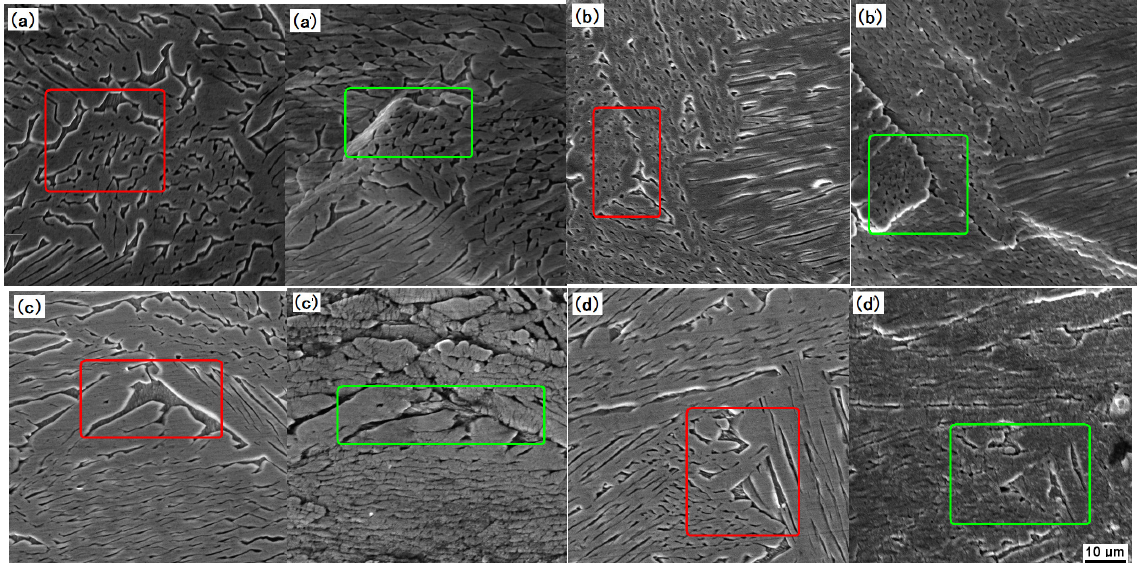
Figure 6. Microstructure before and after upsetting as initial temperature 20 °C, 300 °C, 400 °C and 500 °C: ( a ) 20 °C, ( a’ ) 20 °C after upsetting, ( b ) 300 °C, ( b’ ) 300 °C after upsetting, ( c ) 400 °C, ( c’ ) 400 °C after upsetting, ( d ) 500 °C, ( d’ ) 500 °C after upsetting (The red rectangles are the observation areas before deformation and the green rectangles are the observation areas after deformation).